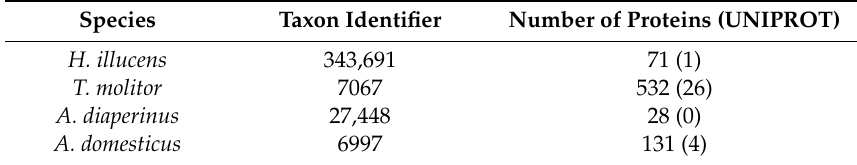
Table 2. Taxon identifier and number of proteins of H. illucens, T. molitor , A. diaperinus and A. domesticus . Species Taxon Identifier